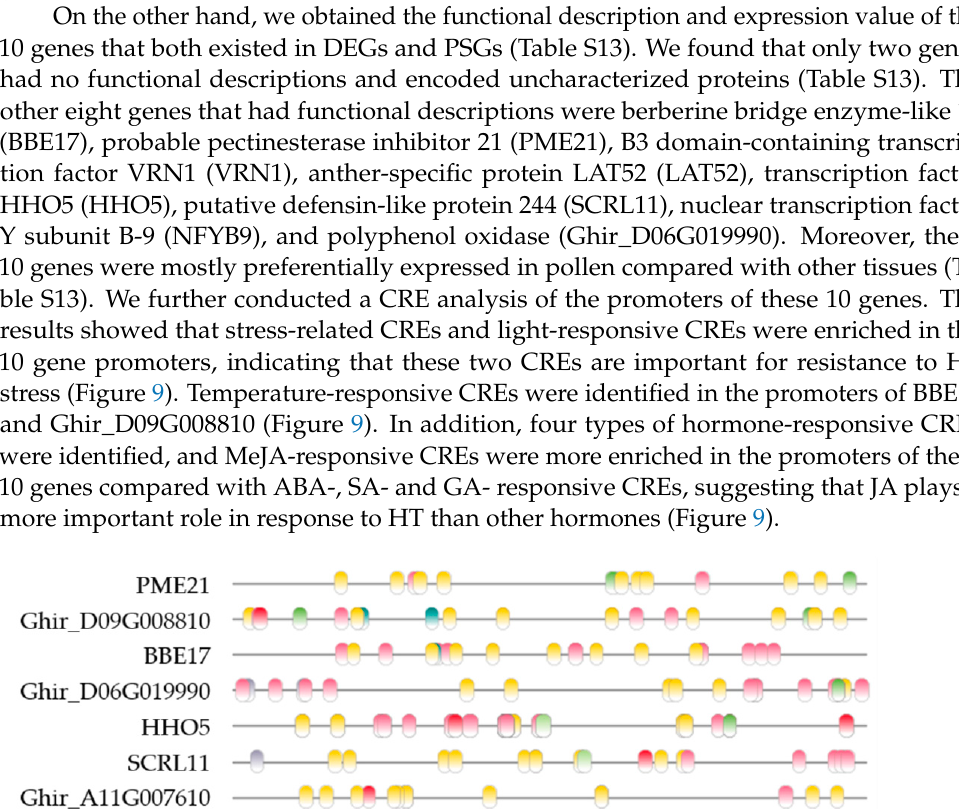
Figure 8. Volcano plot, Venny plot, and GO enrichment analysis of differentially expressed genes (DEGs). ( A ) Volcano plot of DEGs, the x-axis indicates the value of log 2 (FoldChange) and the y-axis indicates the value of − log10 ( p -value); ( B ) Number of up-regulated genes and down-regulated genes; ( C ) Venny plot of PSGs, PAGs, and DEGs; ( D ) GO enrichment analysis of DEGs, the x-axis represents the gene number assigned to a GO term and the y-axis is the list of significantly enriched GO terms.